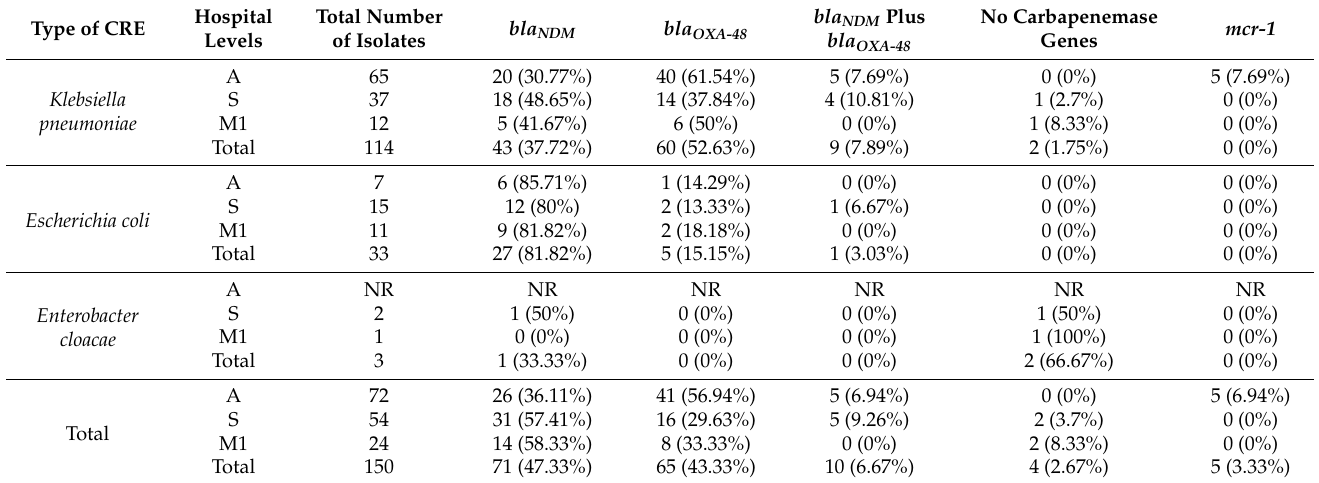
Table 2. Type of carbapenemase genes grouped by the type of CRE at each hospital level.